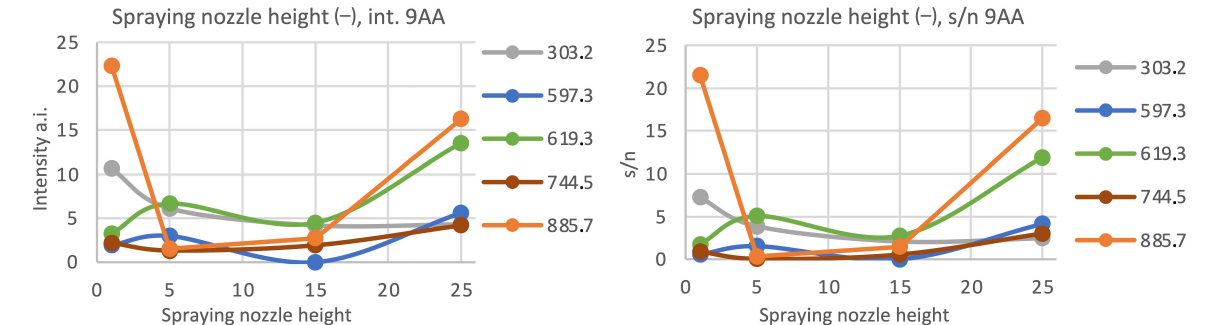
Figure 9. The relationship between the chosen peaks’ intensities and signal-to-noise ratio (s/n) in terms of the spraying nozzle height for the negative ionization mode, matrix: 9AA 7 mg/mL 70% EtOH, number of matrix layers: L = 14.